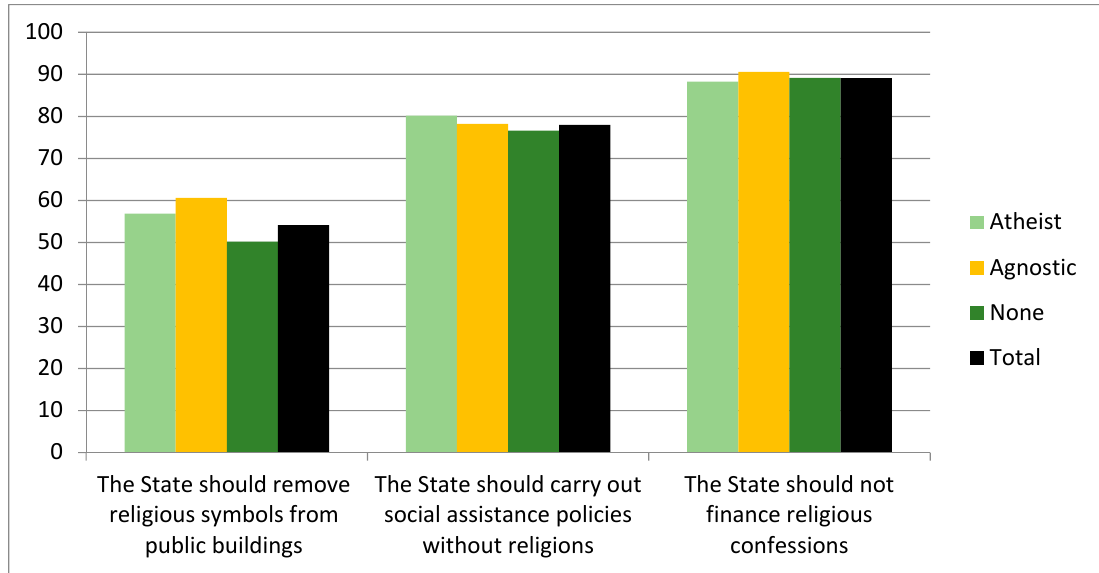
0102030405060708090100 Figure 9. Opinion regarding the relationship between state and churches: degree of agreement with... (in %). Based on 382 cases. Source: Author’s elaboration based on the Second National Survey on Religious Beliefs and Attitudes. Society, Culture and Religion Program, CEIL-CONICET, 2019. Figure 10. Opinion on religious education in public schools (in %). Based on 382 cases. Source: Author’s elaboration based on the Second National Survey on Religious Beliefs and Attitudes. Society, Culture and Religion Program, CEIL-CO- NICET, 2019.